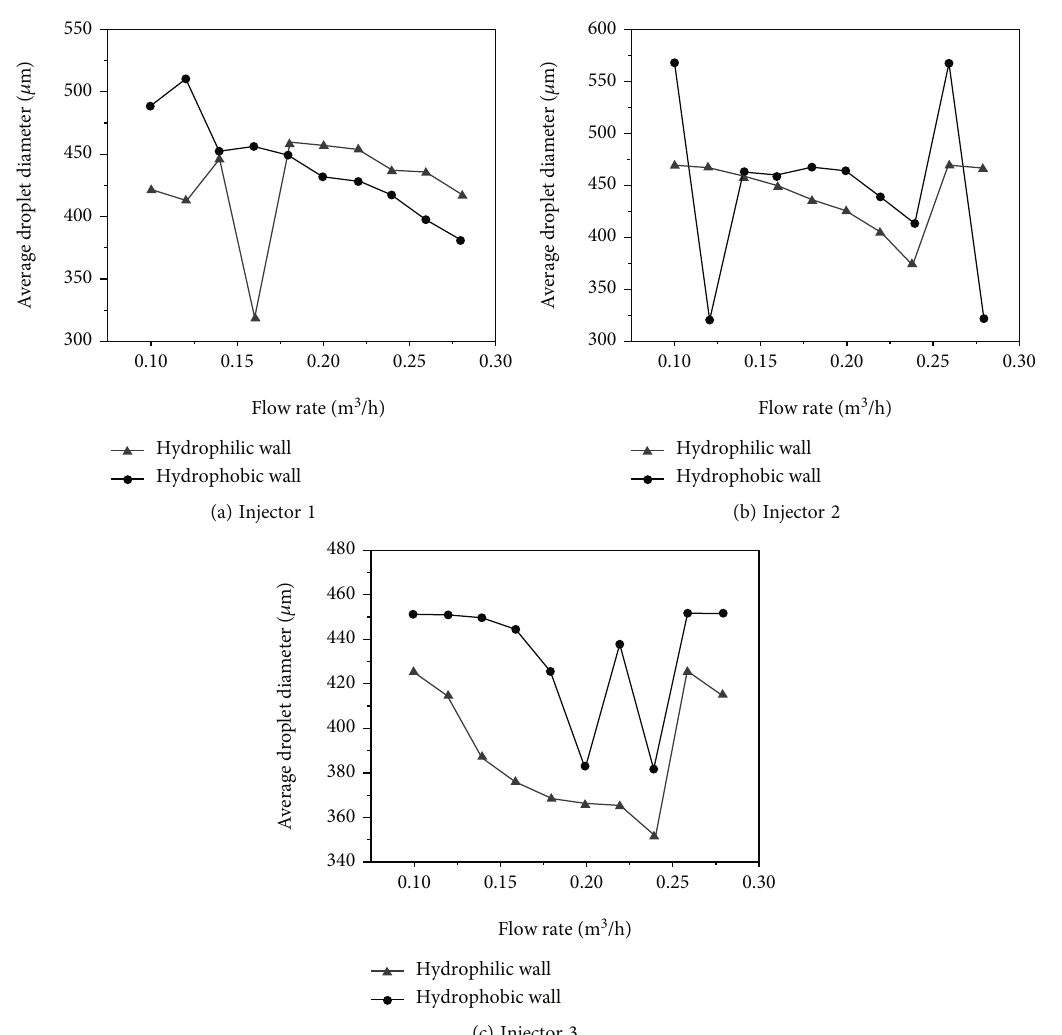
Figure 7: E ff ect of the fl ow rate on the average droplet diameter in di ff erent injectors.